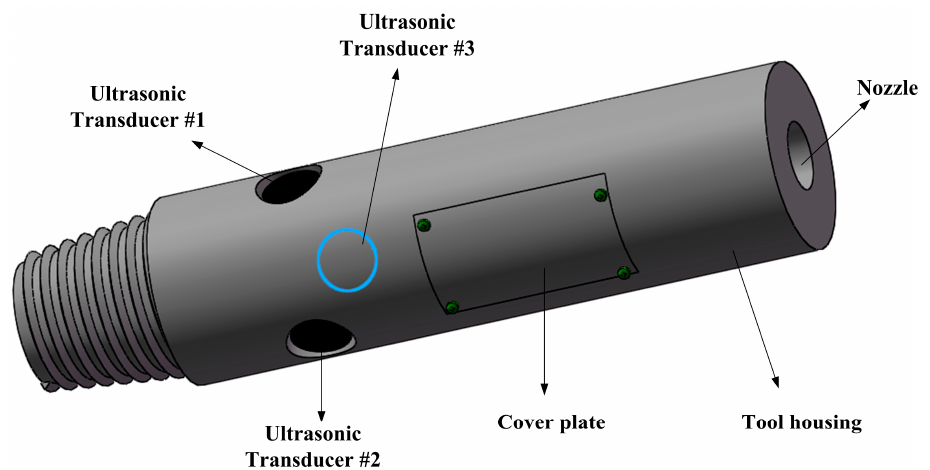
Figure 1. Mechanical profile of the ultrasonic LWD caliper.